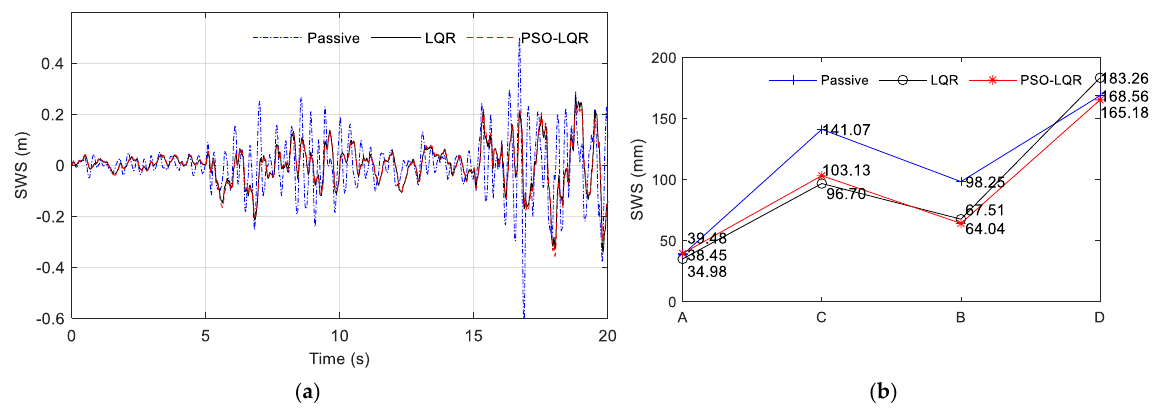
Figure 17. SWS comparison diagram of mode switching on the variable road surface. ( a ) Time domain variation curve of A–C–B–D road section. ( b ) RMS value of A–C–B–D road section.